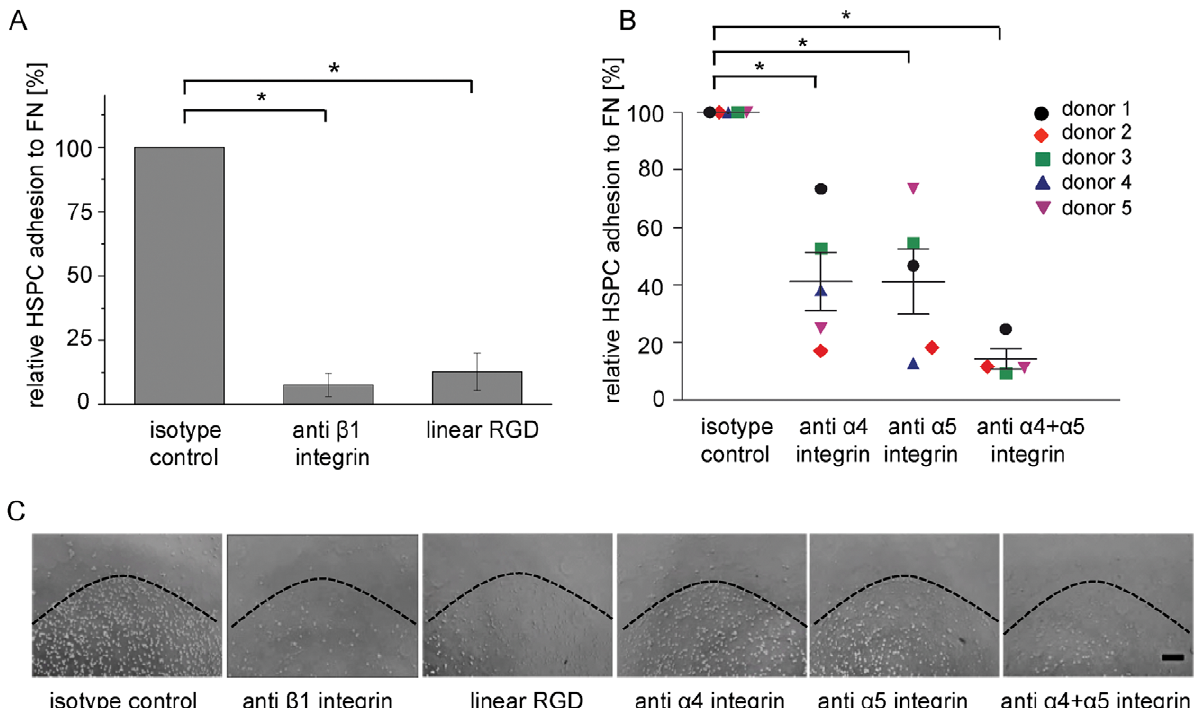
Figure 4. Integrin-mediated HSPC adhesion to FN. HSPCs were preincubated with integrin-specific antibodies or a linear RGD peptide for 1 h and plated onto an adsorbed FN spot. After nonadherent cells were removed, the spots were imaged and the adherent cells counted. (A) Relative HSPC adhesion to FN was either inhibited by preincubation with antibodies blocking the b 1 integrin chain or with a linear RGD peptide. The isotype control (set to 100%) shows cell adhesion to FN after preincubation with isotype control antibodies. N independent experiments= 4. (B) HSPC adhesion to FN was significantly reduced when inhibiting either the a 4 integrin chain, the a 5 integrin chain or both. N independent experiments= 5. (A, B) Error bars=standard error of the mean; *=significant p value , 0.05 in Wilcoxon rank sum test. (C) Representative microscopic images of HSPC adhesion to FN spots. Cells are visible as white spots in the lower part of each image, the dashed black line indicates the border of the FN spot. Scale bar=200 m m.